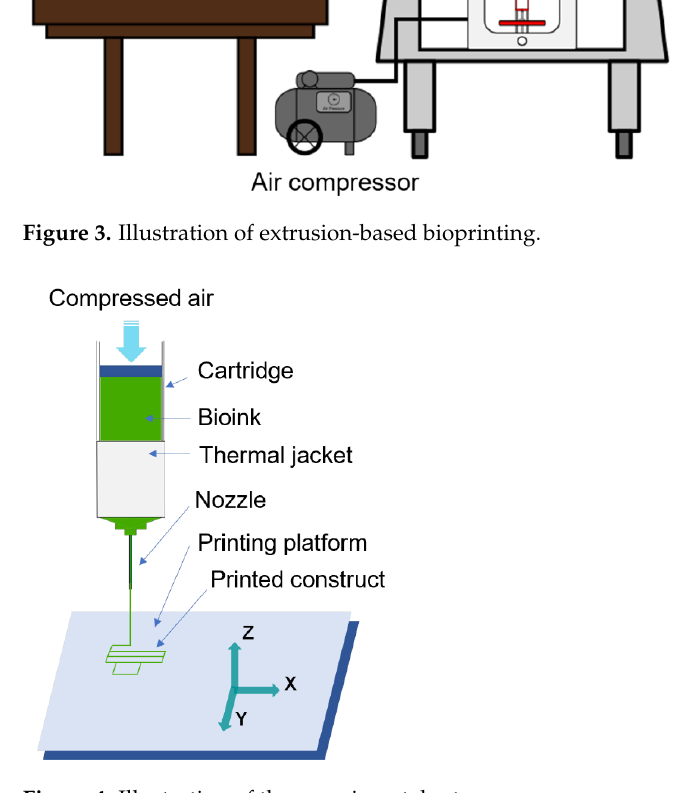
Figure 4. Illustration of the experimental setup.